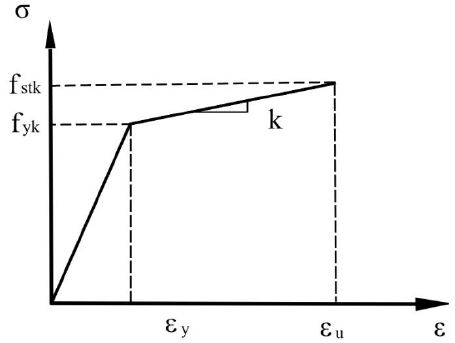
Figure 12. Bilinear constitutive model of steel.